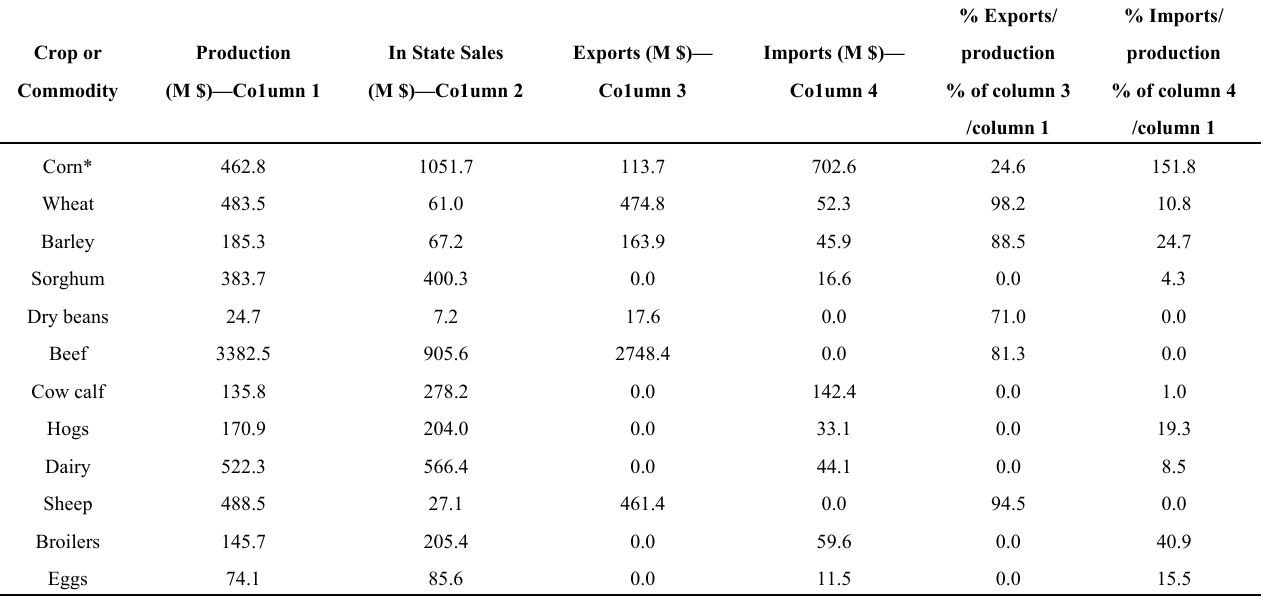
Table 1. Production, in-state sales, exports, and imports of key Colorado agricultural